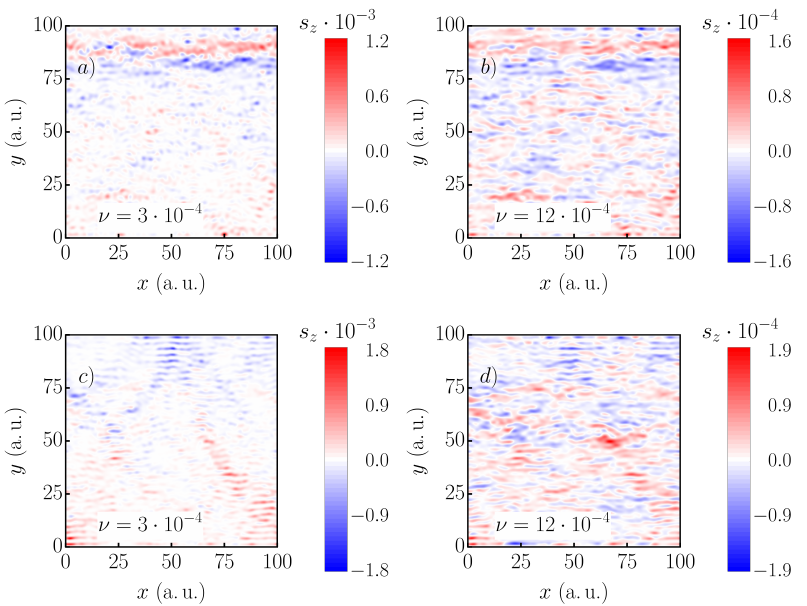
Figure 6. The local density of states for a square x -periodic system, lengths 100a.u. with α = 20meVÅ, B = 1T with ten impurities of strength M = 0.18a.u., and FWHM = 8a.u. The density of the 1821st ( a , b ) and 2424th ( c , d ) are shown. Panels ( a , c ) were calculated using ν = 3 × 10 − 4 , ( b , d ) using ν = 12 × 10 − 4 a.u., which corresponds to 16 and 72 averaged states, respectively. The spin- polarization is decreased by one order of magnitude when the number of summed states is